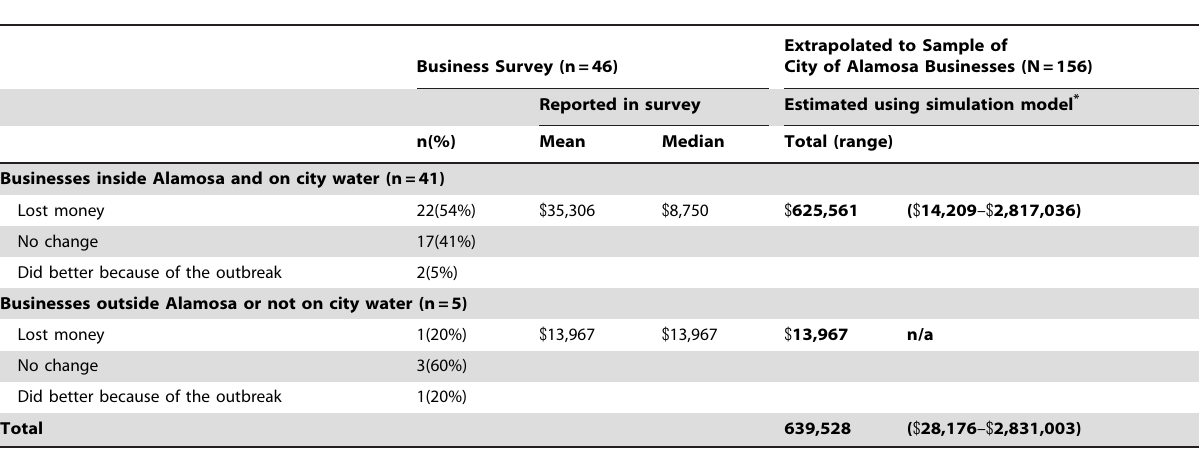
Table 6. Outbreak-associated costs to City of Alamosa businesses associated with an outbreak of salmonellosis, Alamosa, Colorado